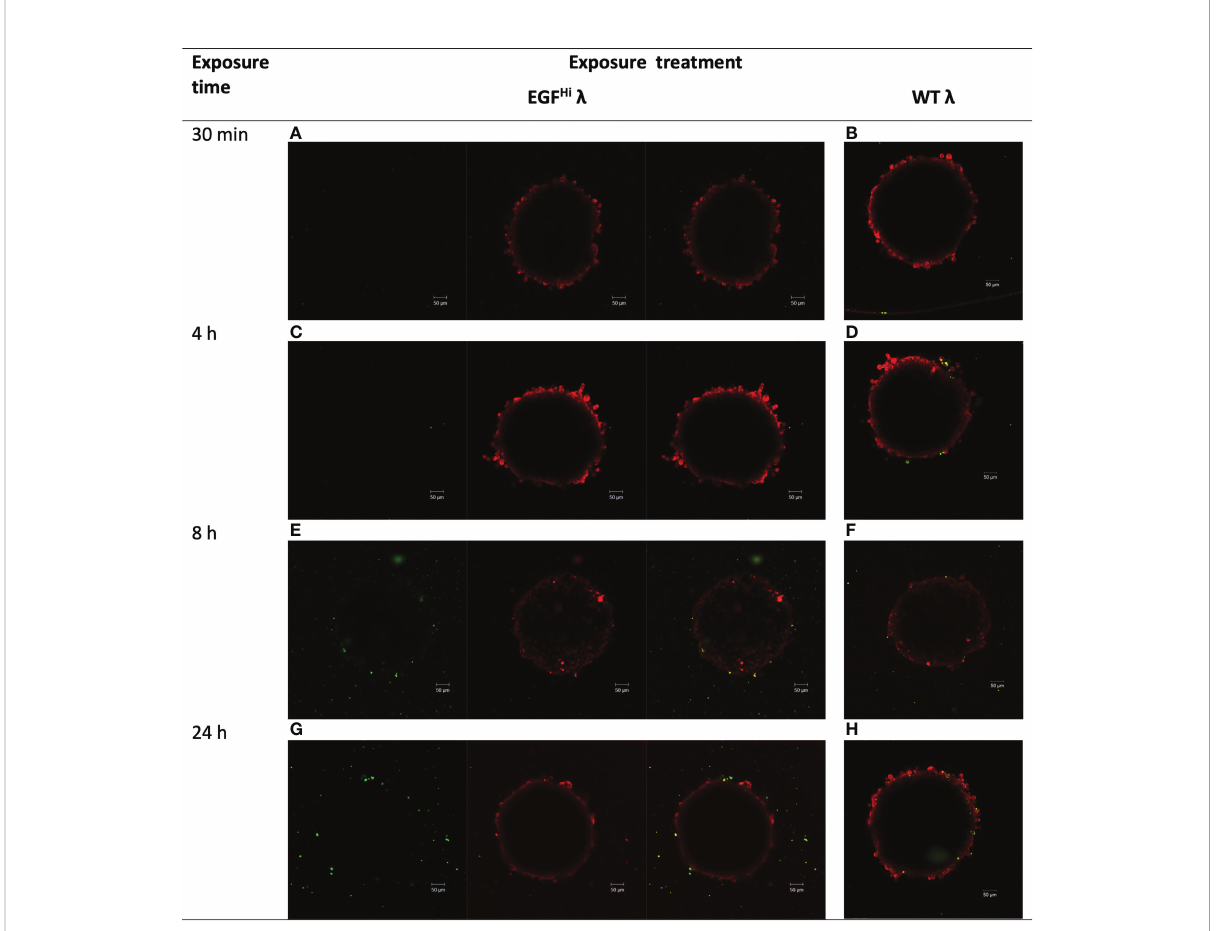
FIGURE 4 l phages accumulate in HT-29 colorectal cancer spheroids, and the accumulation/distribution is altered by EGF displayed on the capsid surface. HT-29 spheroids (d6, ~300 m m diameter) were treated with WT l or EGF Hi l phages, each tagged with Alexa Fluor488 (green). Spheroids were washed to discard unbound phages and counterstained with CellTracker ™ Red prior to imaging by confocal microscopy. Panels show the images at the successive timepoints noted, for EGFHi l (panels A, C, E, G ) or WT l (panels B, D, F, H ). Images are from a z plane 64 m m below the surface of the spheroids, except for panel E (42 m